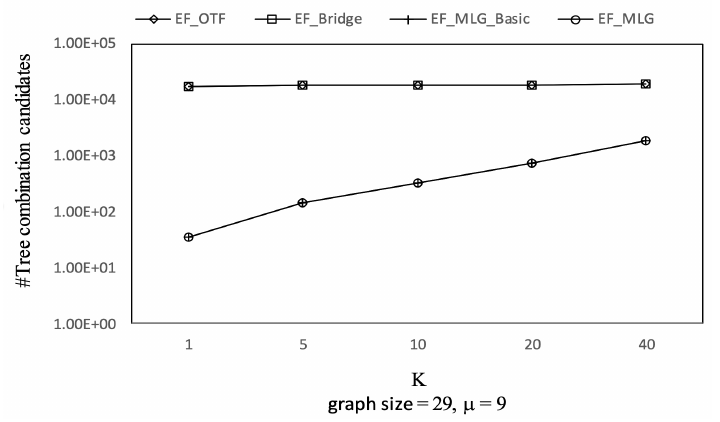
Figure 17. Tree combination pruning on Ncfu vs. k with graphsize = 29 and µ = 9.